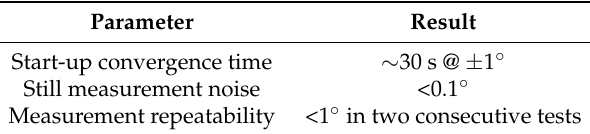
Table 9. Measurement performances